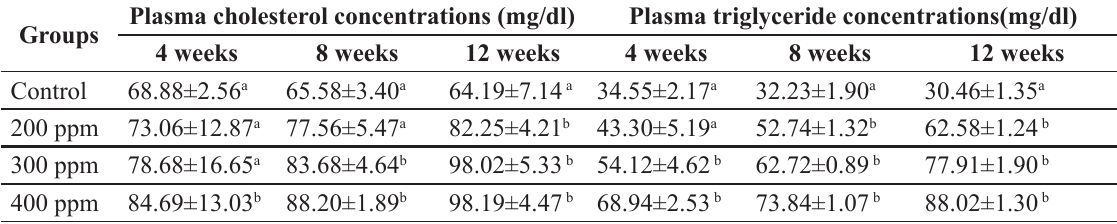
Table 2: The mean plasma cholesterol and triglyceride concentrations of male Albino rats treated with graded doses of lead for a period of four, eight and twelve weeks.